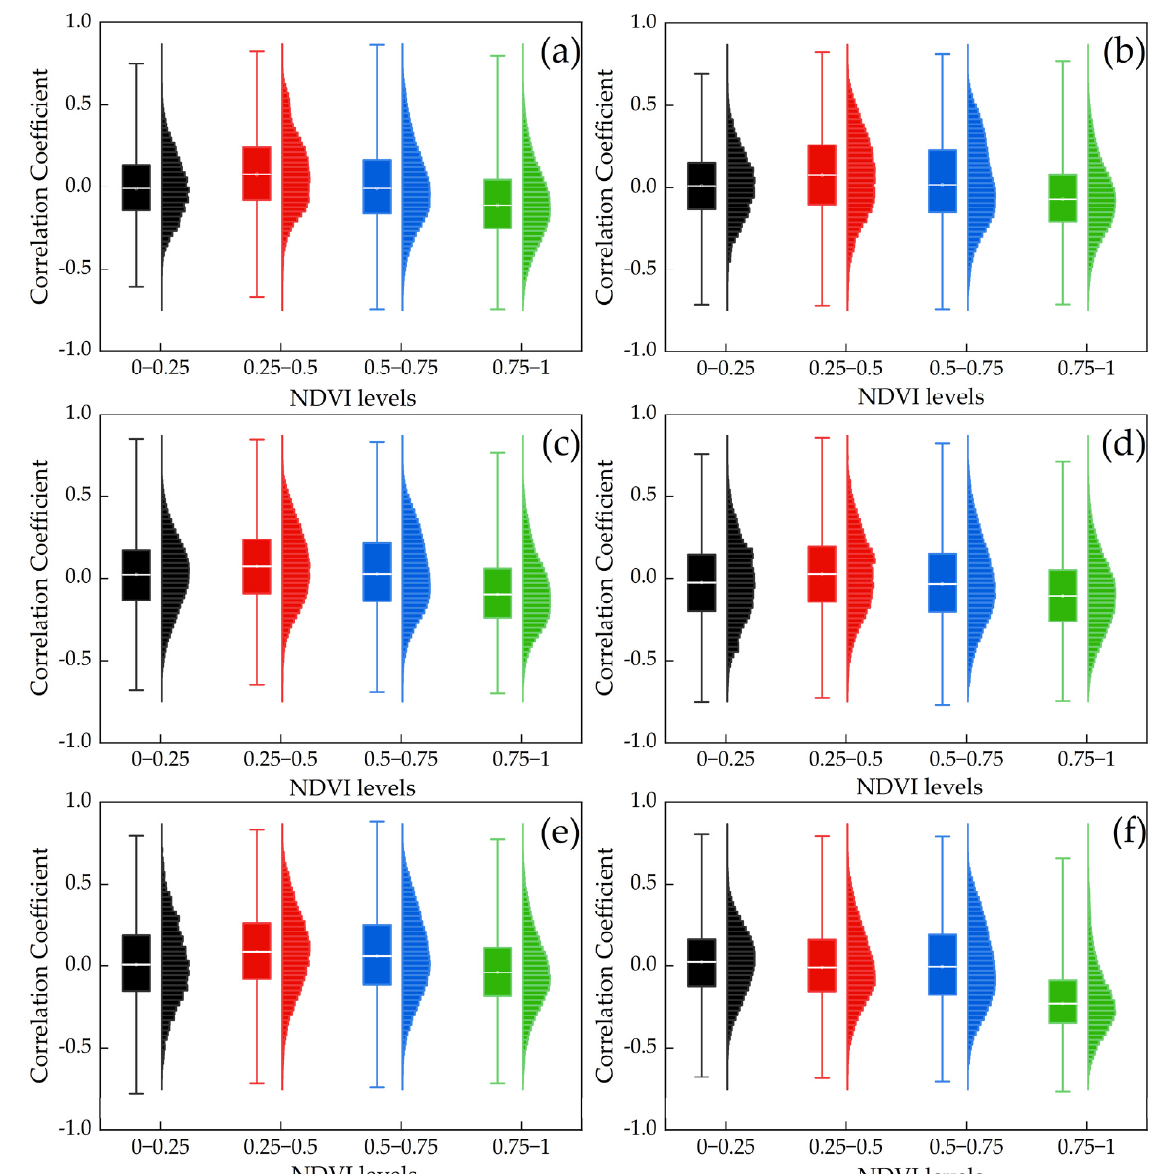
Figure 7. Correlations between different NDVI levels and SPEI under different vegetation types: ( a ) cropland; ( b ) forest; ( c ) grassland; ( d ) water; ( e ) urban land; and ( f ) unused land.